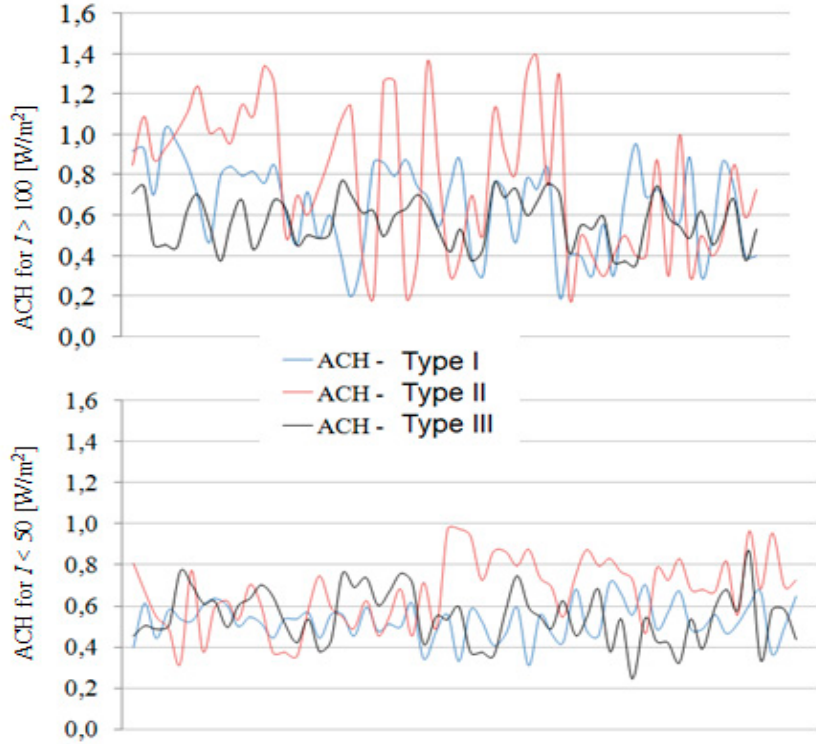
Figure 19. Summary of ACH results during sunny and cloudy periods.